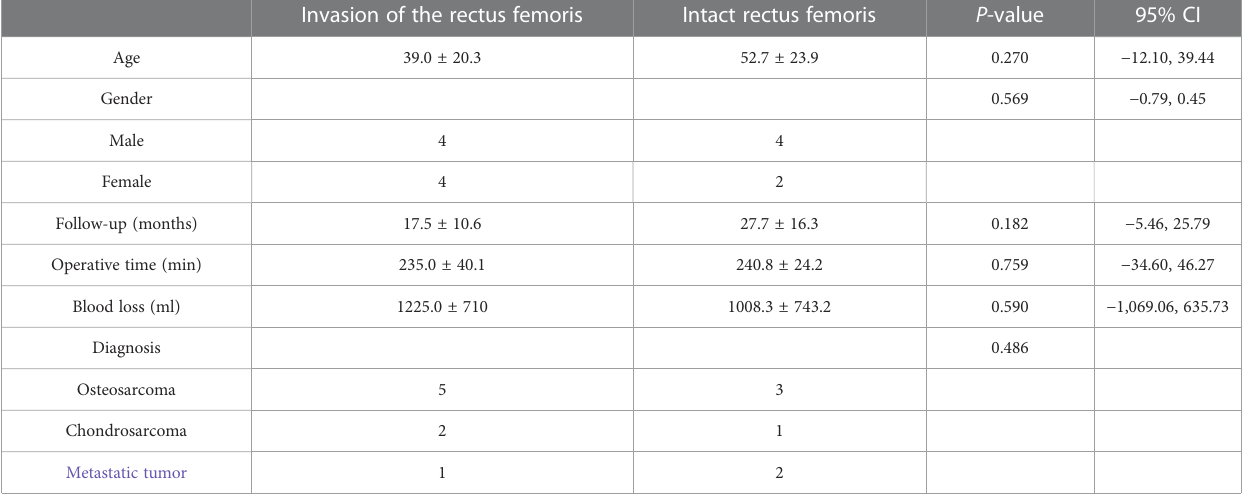
TABLE 2 Demographic and clinical characteristics of the included patients strati fi ed by invasion of the rectus femoris or an intact rectus